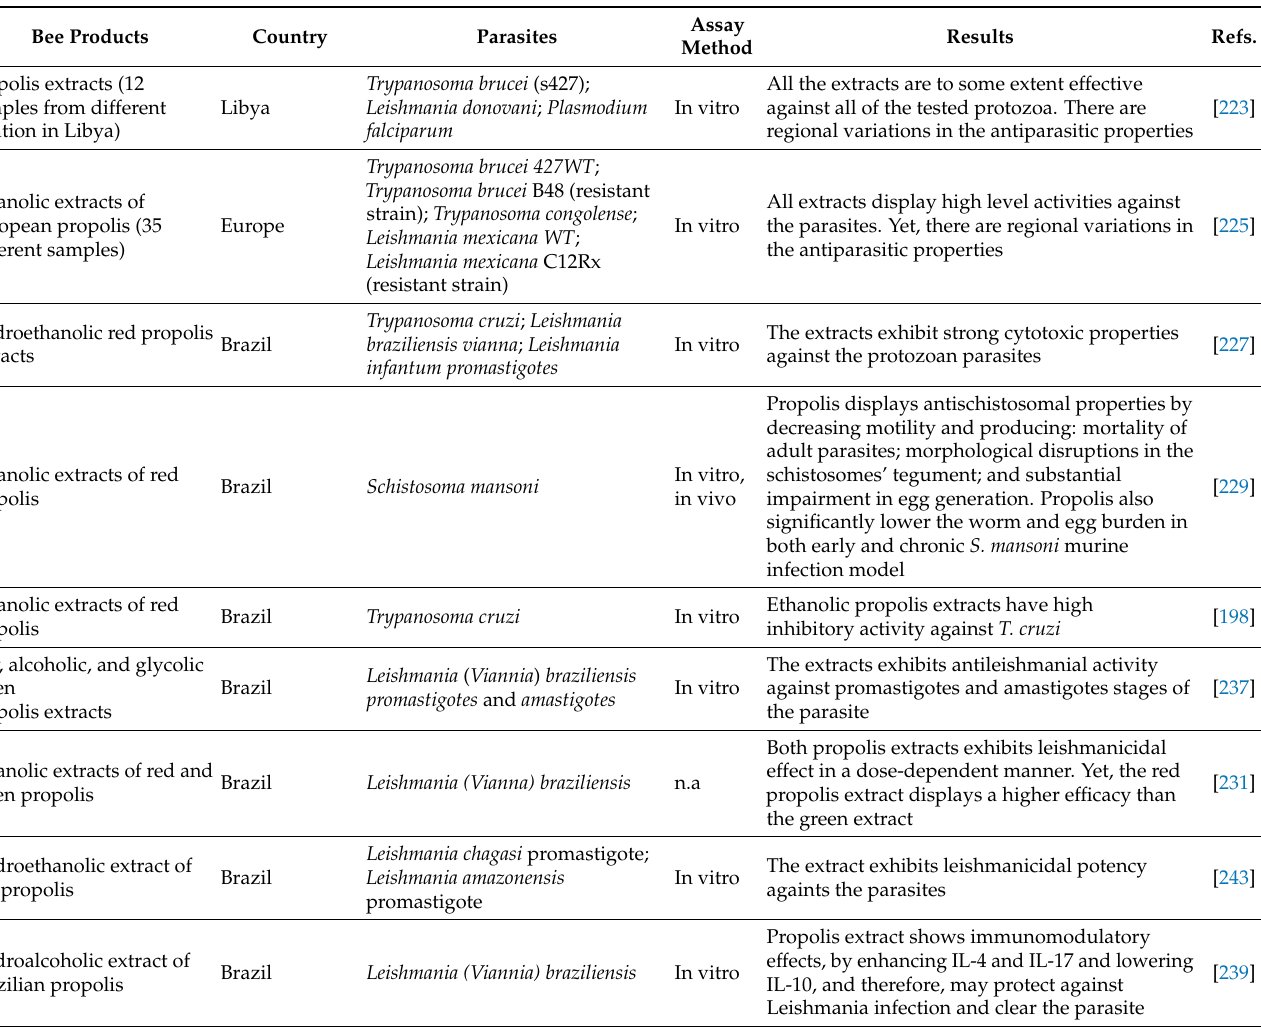
Table 3. Antiparasitic effect of selected bee